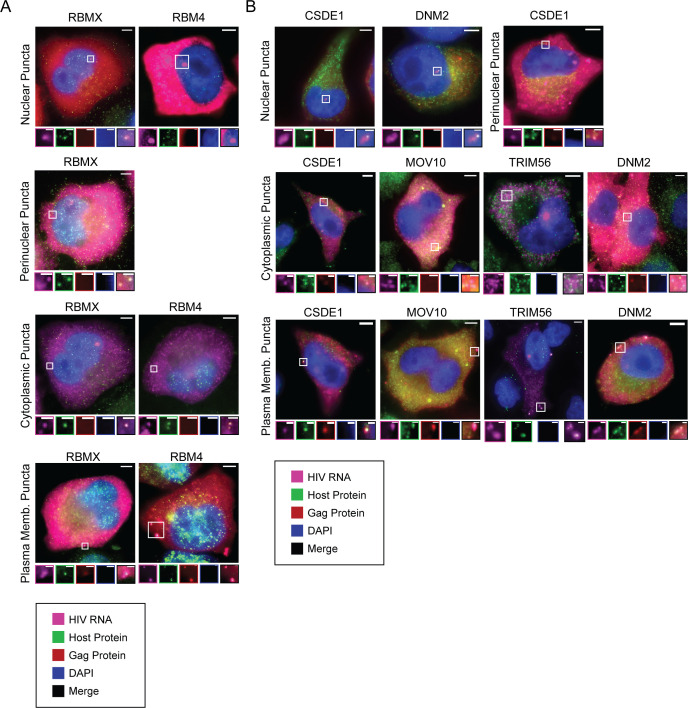
Representative images of host proteins co-localizing with unspliced (US) HIV RNA.(A) Two host proteins (RBMX and RBM4), in addition to HNRNPR discussed above, primarily localize to the nucleus and are observed to co-localize to nuclear puncta frequently (82% and 96%, respectively). The image showing RBM4 (negative effector) co-localization with US HIV RNA at nuclear puncta is enlarged to show co-localization at small puncta near the putative HIV transcription site. (B) Proteins (CSDE1, MOV10, TRIM56, DNM2) primarily localize to the cytoplasm and frequently co-localize with US HIV RNA at cytoplasmic puncta (>71%) and plasma membrane puncta (>31%).